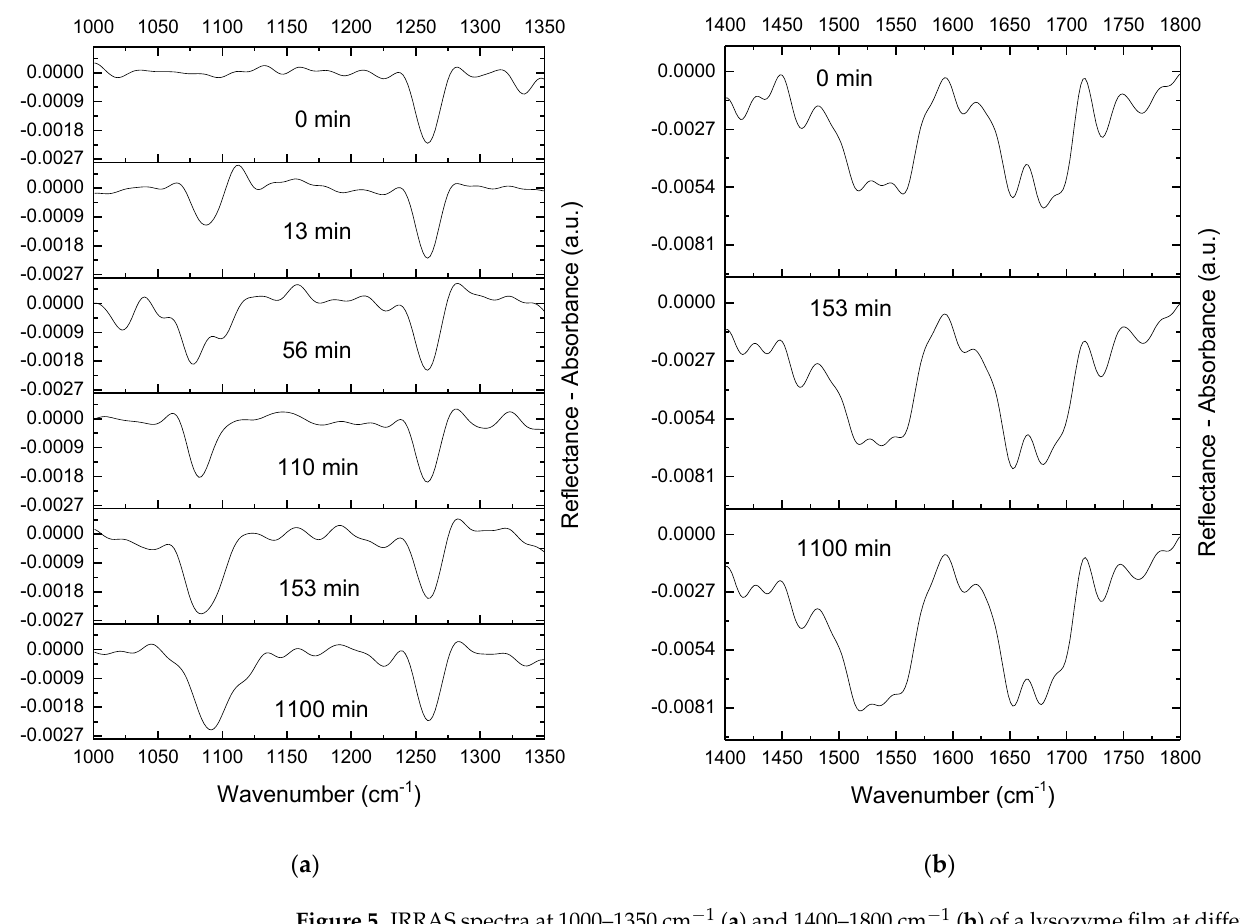
Figure 5. IRRAS spectra at 1000 – 1350 cm −1 ( a ) and 1400 – 1800 cm −1 ( b ) of a lysozyme film at different times after DNA injection into the subphase. The total DNA concentration is 50 µM. The 2-fold surface compression leads to a gradual increase in the intensity of both DNA phosphate bands (Figure 6a). The intensity of the bands reaches constant values approximately 2 h after compression. This period can correspond to a relatively slow reorganization of the surface layer structure. Note that the intensity of these bands is not reduced upon compression, thereby indicating that DNA is not expelled into the subphase and the large folds, which are observed by AFM at high surface pressures; they are caused by DNA molecules surrounded by the protein in the layer (Figure 3c,d). The intensity of amide II and amide I bands of lysozyme after surface compression reaches constant values faster than the intensity of the DNA phosphate bands, presumably due to the greater mobility of lysozyme molecules in the surface layer compared to DNA strands (Figure 6b). This increase in the intensity of spectrum bands corresponds to the formation of a thick lysozyme layer, as can be observed in the AFM images (Figure